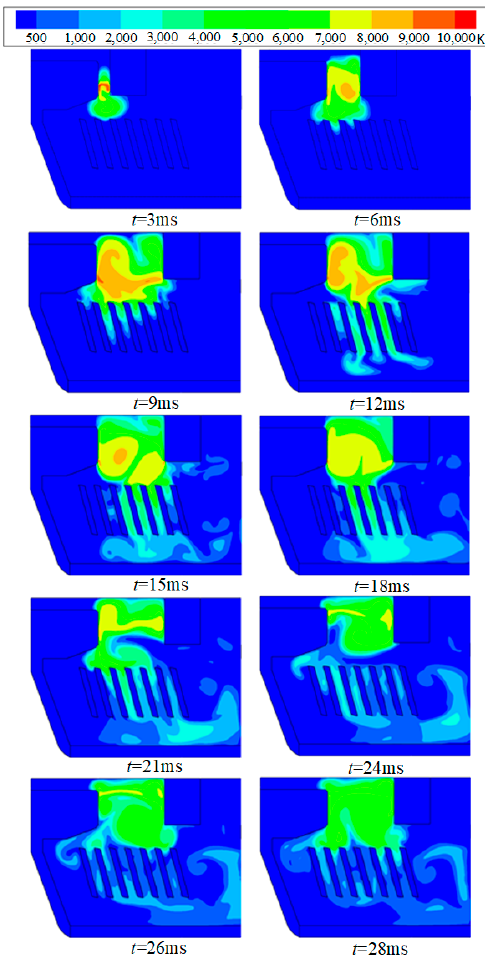
Figure 8. Temperature distribution of arc (DC 1500 V).